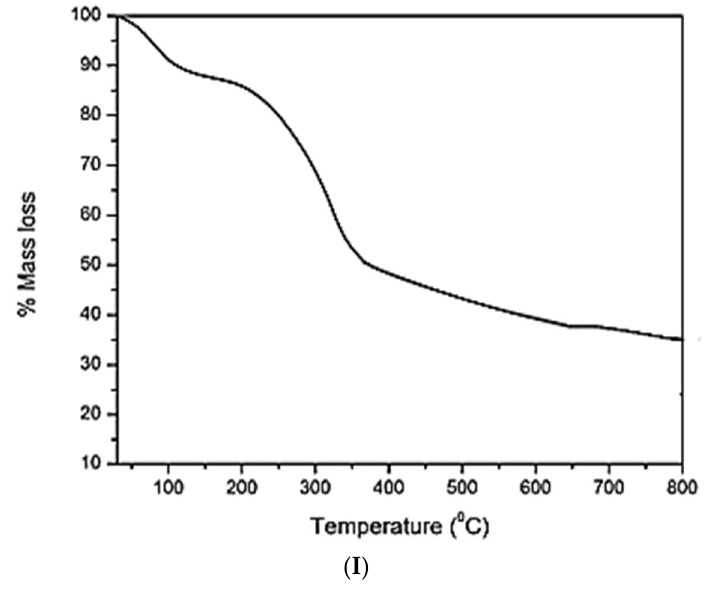
Figure 1. ( A ) Unloaded CMPVL FTIR Spectrum ( B ) Loaded CMPVL FTIR Spectrum( C ) SEM image of untreated Pteris vittata leaves powder ( D ) SEM image of CMPVL ( E ) SEM image of Fe(II) loaded CMPVL ( F ) EDX plot for CMPVL ( G ) EDX plot for Fe(II) loaded CMPVL ( H ) TGA for untreated Pteris vittate leaves powder ( I ) TGA plot for CMPVL.